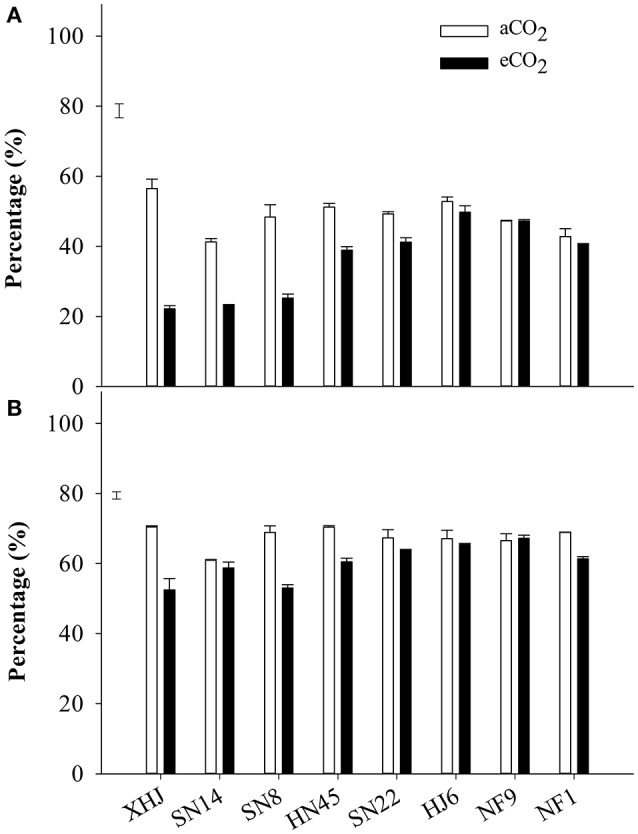
The percentage of (A) remobilized N in seed and (B) the percentage of N remobilized from vegetative organs to seeds of eight cultivars grown under aCO2 or eCO2. The error bars represent standard error, and the separate vertical bar in each panel indicates the LSD (P < 0.05) for the CO2 × cultivar interaction.